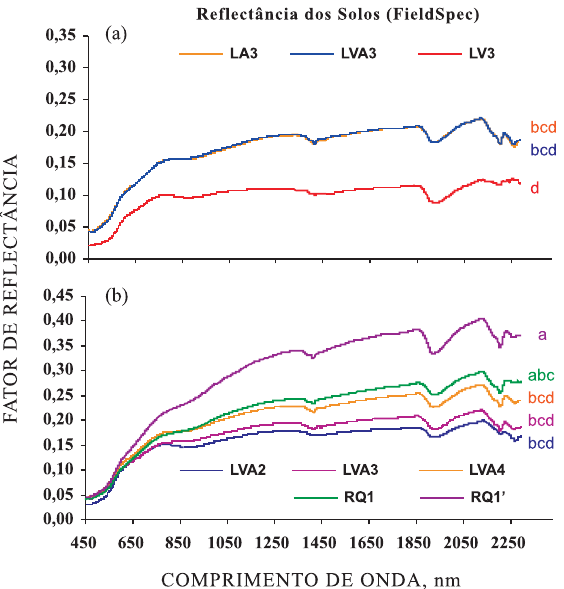
Figura 4. Reflectância de diferentes subordens de Latossolos com classes texturais semelhantes (a) e de mesmas subordens de solos, porém com diferentes texturas (b), obtidas pelo sensor FieldSpec para amostras da camada s uperficial.